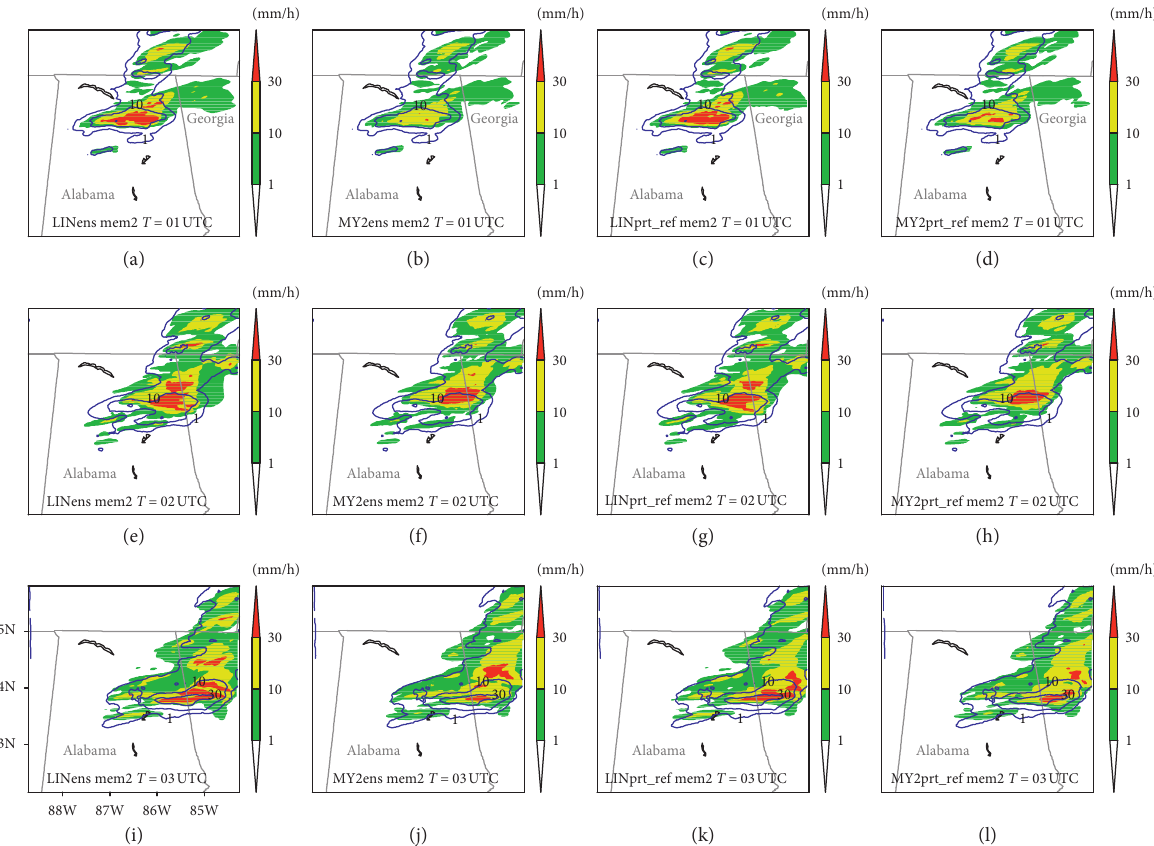
Figure 7: Hourly precipitation rate from the observations (contour) and (a, e, i) LINens, (b, f, j) MY2ens, (c, g, k) LINprt_ref, and (d, h, l) MY2prt_ref at 01 ZUTC (upper panels), 02 ZUTC (middle panels), and 03 ZUTC (lower